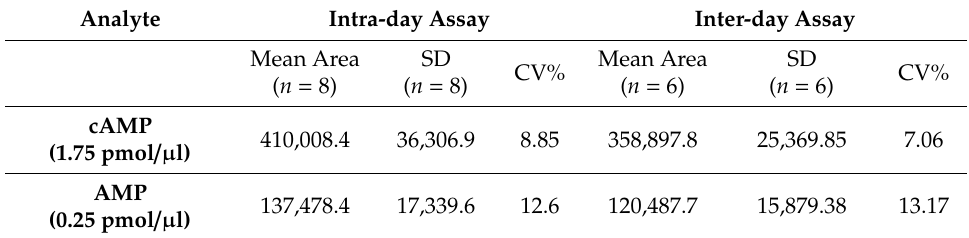
Table 2. Intra- and inter-day assay of cAMP and AMP by comparing mean peak area, in terms of standard deviation (SD) and coefficient of variation CV%.